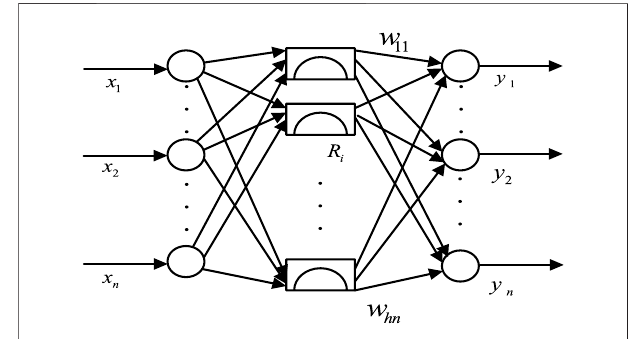
FIGURE 9 | RBF neural